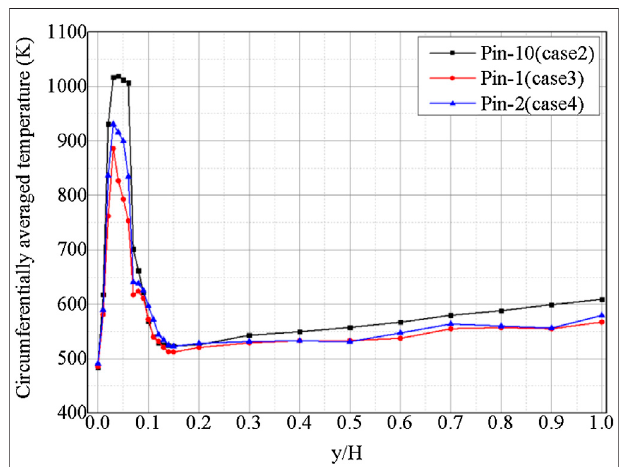
FIGURE 11 | Variation of the circumferentially averaged temperature on pin 1, 2, and 10 along the axial position.